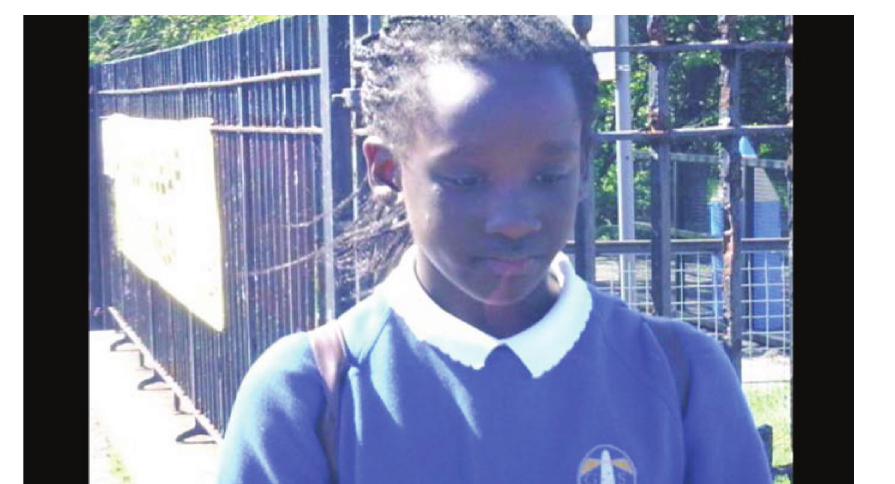
Figure 14: Khadija leaves school feeling happy in herself Khadija and Maggie are now at high school, and meeting them half a year after their experiences with Understanding Cinema, Khadija already seems noticeably